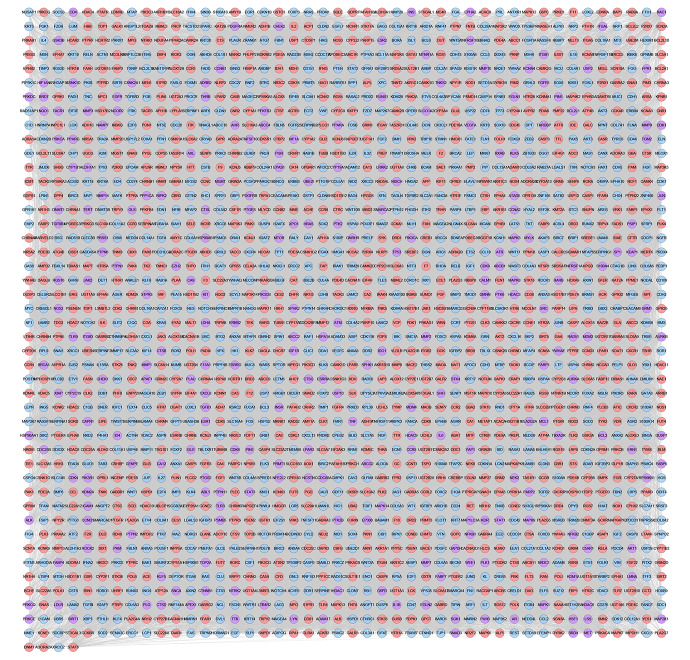
XHP-TNBC PPI Network (Purple circle stands for XHP-TNBC; Blue circle stands for TNBC genes; Pink circle stands for XHP targets.)